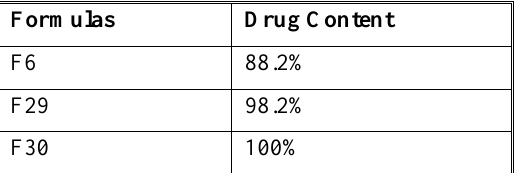
Table 4.The drug content in the selected sc periodontal in situ gel